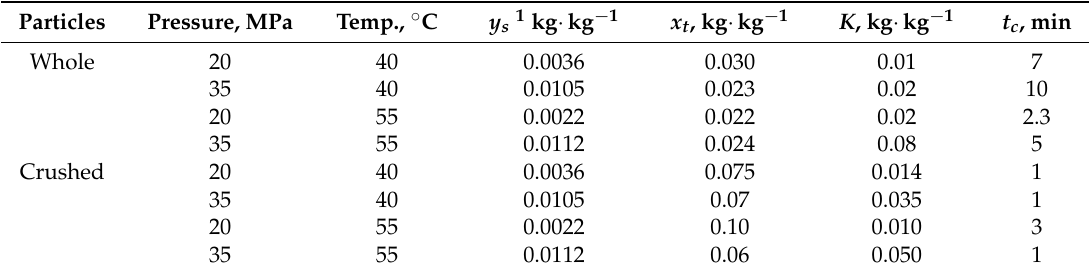
Model parameters for the extraction of lipids from Chlorella vulgaris [7] ( N = 5